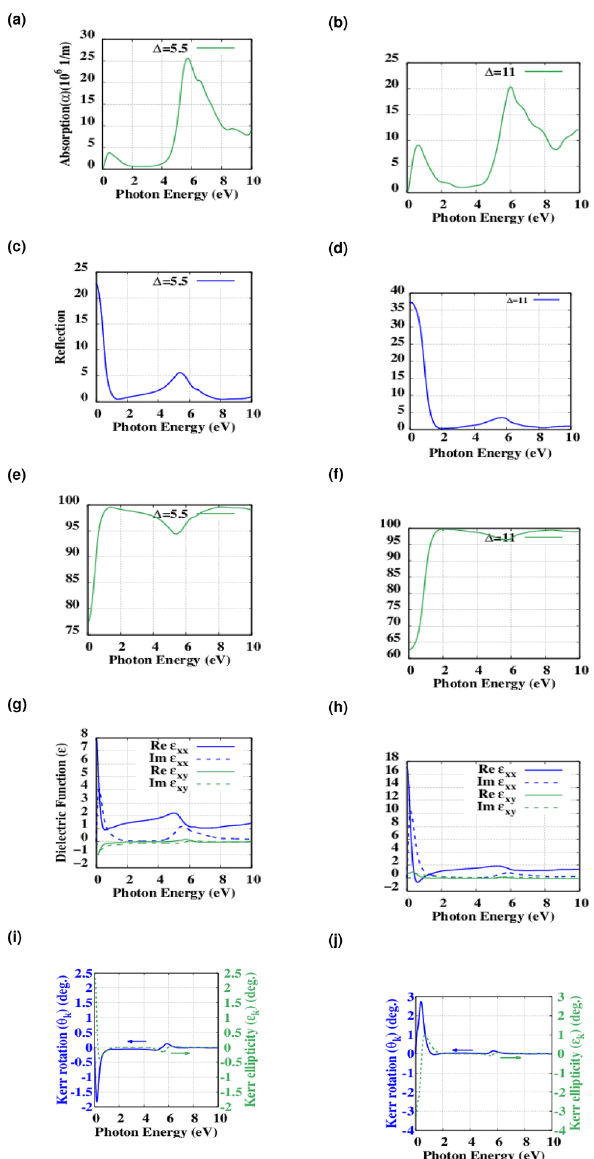
Figure 9. ( a , b ) The optical absorption spectrum of (cid:31) = 5.5 and 11% Oxygen doped hBN. ( c , d ) Calculated spectra of reflection for (cid:31) = 5.5 and 11% Oxygen doped hBN. ( e , f ) Calculated spectra of reflection for (cid:31) = 5.5 and 11% Oxygen doped hBN. ( g , h ) calculated real part (solid lines) and imaginary part (dashed lines) of both diagonal ε xx (blue) and off-diagonal ε xy (green) dielectric functions of (cid:31) = 5.5 and 11% Oxygen doped hBN. ( i , j ) Kerr angle θ K (left, blue solid) and Kerr ellipsity χ K (right, green dashed) of (cid:31) = 5.5 and 11% Oxygen doped hBN in the P-MOKE